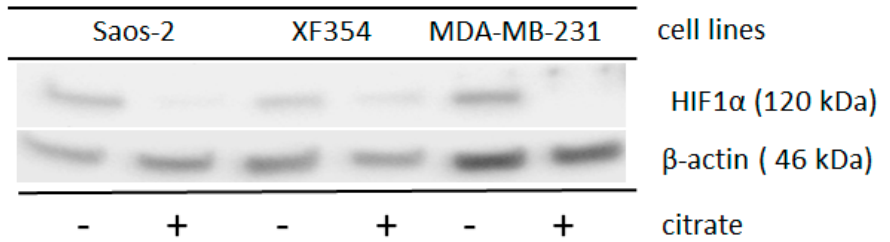
Figure 5. Altered HIF1 α expression after the application of sodium citrate in cells of different lineages under normoxia after simultaneously treatment with glutamine. Saos-2, XF354 and MDA-MB-231 cells were treated with 8 mM (the XF354 cells were treated with only 4 mM sodium citrate) in RPMI 1640 medium with 5 mM glutamine under normoxic conditions for 24 h. Western blot analysis was performed with anti-HIF1 α monoclonal antibody and anti- β -actin monoclonal antibody as a control. Sodium citrate significantly reduces the glutamine-induced normoxic HIF1 α -level. Data are from three independent experiments (Please see Supplemental Figure S10 and the results from the densitometric evaluation of the Western blots).